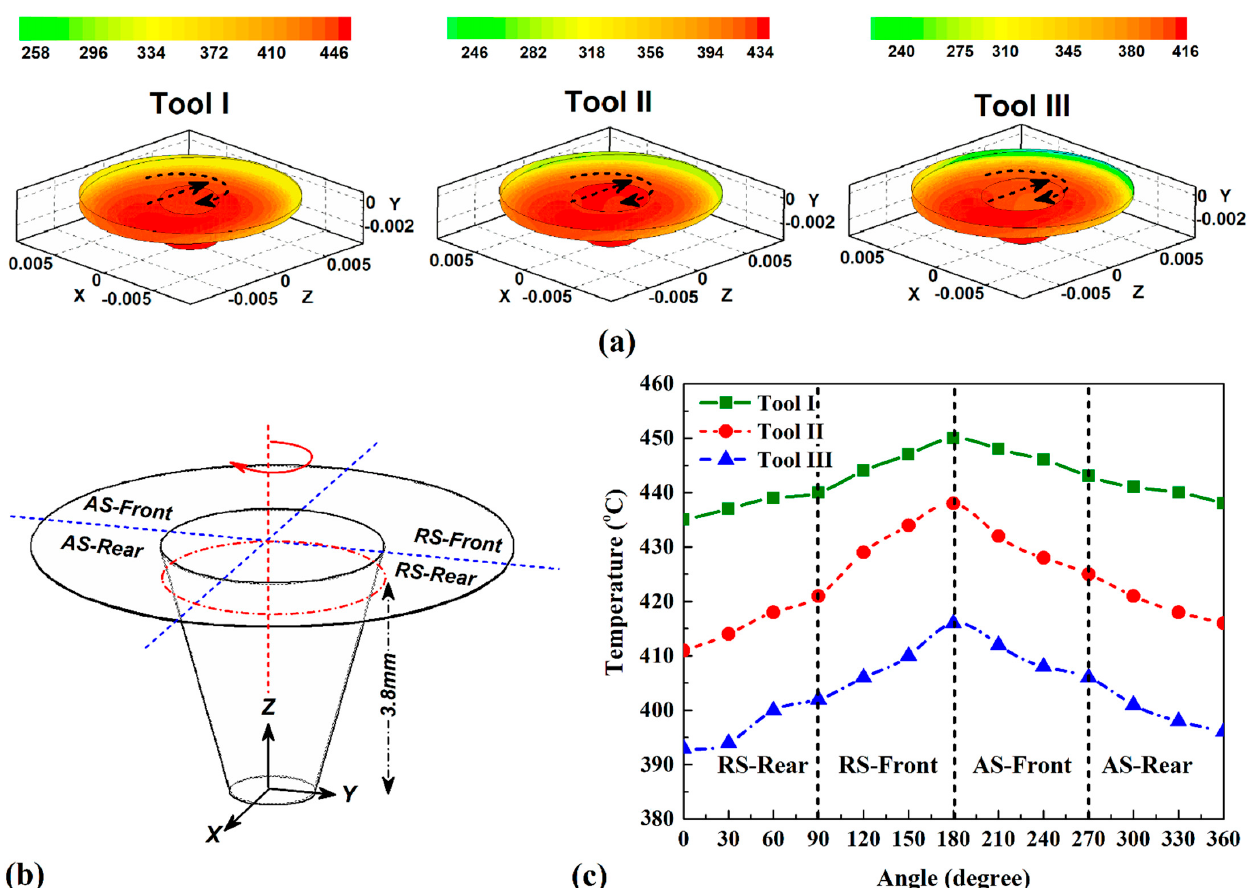
Figure 4. ( a ) simulation results of heat generation in stir zone, ( b ) schematic view of selected plan for recording data, ( c ) simulation results of heat distribution around various tools.